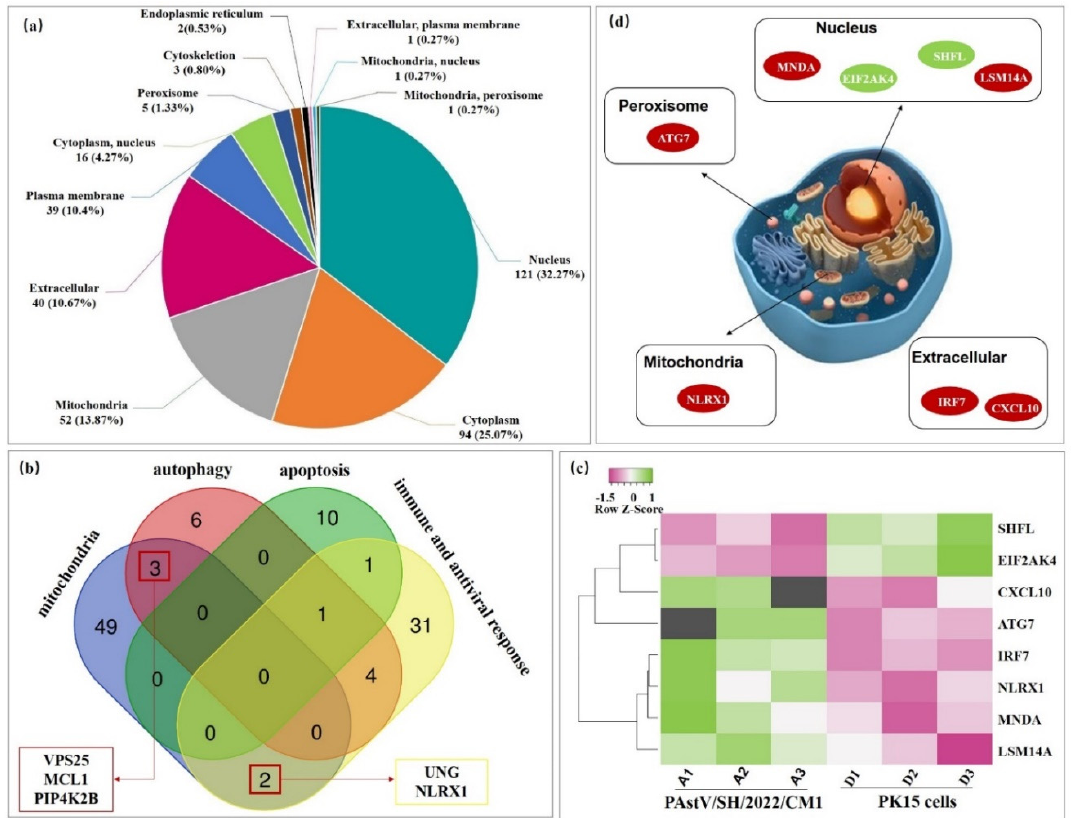
Figure 5. Functional characterization of the DEPs in organelles. ( a ) Subcellular localization analysis of DEPs. ( b ) Venn diagrams show the differentially expressed proteins (DEPs) (shared or unique) between each comparison (http://bioinformatics.psb.ugent.be/webtools/Venn/, accessed on 15 May 2022). ( c ) DEPs that participated in the defense response to the virus were screened and analyzed by Heatmapper (http://www.heatmapper.ca/expression/, accessed on 15 May 2022). Green refers to upregulated DEPs, while pink refers to downregulated DEPs. ( d ) Subcellular location of the DEPs involved in the defense response to the virus.